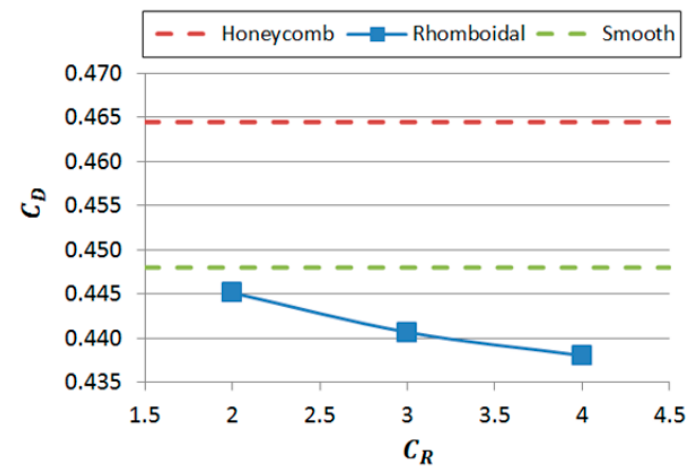
Figure 6. Discharge coefficient for the analyzed patterns. Table 6. C d percentage variation.